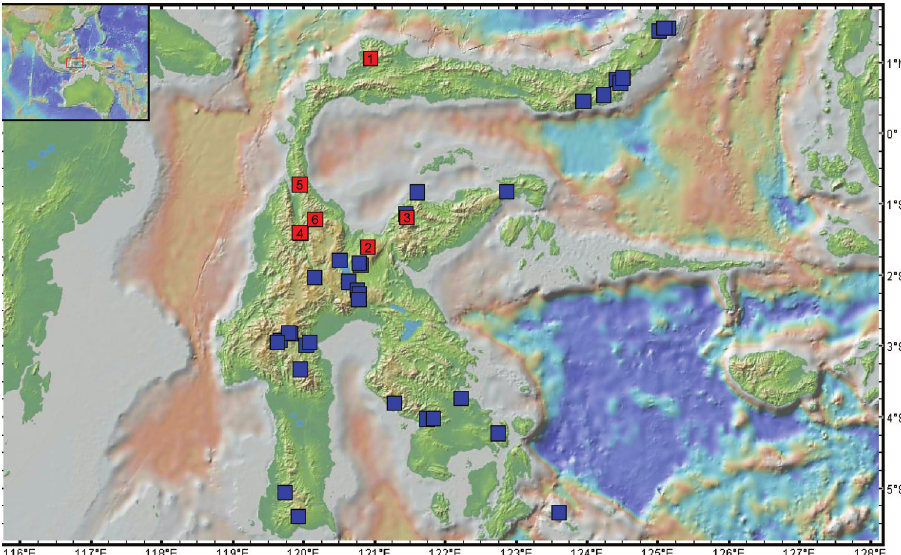
Figure 29. Map of Trigonopterus records across Sulawesi and adjacent islands. Blue dots from Riedel and Narakusumo (2019); white dots from present study. Prepared using GeoMapApp (www.geomapapp.org; Ryan et al. 2009); 1 = Mt Dako ( T. acutus sp. nov., T. ancora sp. nov., T. arcanus sp. nov., T. corona sp. nov., T. dakoensis sp. nov., T. daun sp. nov., T. gundala sp. nov., T. hoppla sp. nov., T. moduai sp. nov., T. mons sp. nov., T. paramoduai sp. nov., T. puspoi sp. nov., T. rosichoni sp. nov., T. rubidus sp. nov., T. sutrisnoi sp. nov., T. tanah sp. nov., T. tolitoliensis sp. nov.; 2 = Mt Pompangeo ( T. ewok sp. nov., T. kakimerah sp. nov., T. matakensis sp. nov., T. pomberimbensis sp. nov., T. pompangeensis sp. nov., T. tejokusumoi sp. nov., T. unyil sp. nov.); 3 = Mt Katopasa ( T. katopasensis sp. nov., T. tounensis sp. nov.); 4 = Mt Torompupu ( T. sarinoi sp. nov.); 5 = Palu ( T. toboliensis sp. nov.); 6 = Palolo ( T. toboliensis sp.